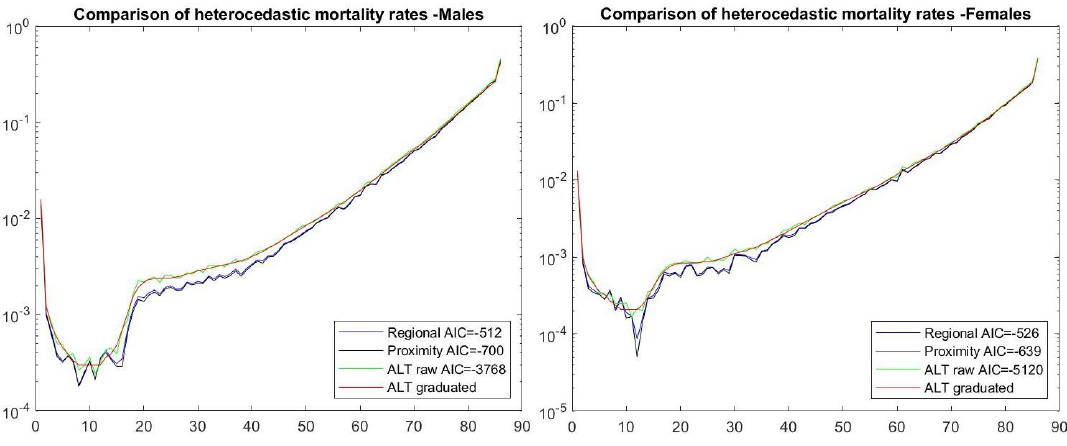
Figure 2. Regional mortality